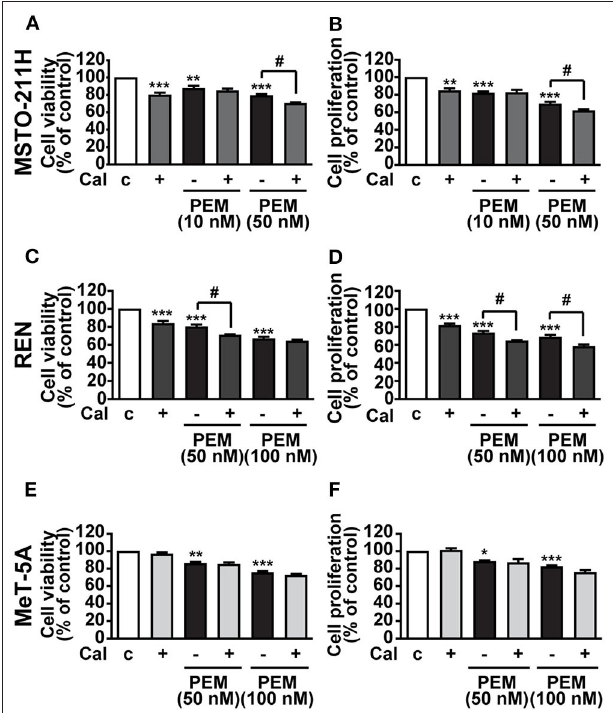
FIGURE 3 | Inhibitory effects of calcitriol in combination with PEM. Cell viability and proliferation assessed by MTT and BrdU, respectively, in MSTO-211H (A,B) and REN (C,D) cell lines, and in MeT-5A mesothelial cells (E,F) treated for 72h in medium with 2.5% serum (c, control) and with either 100nM calcitriol (Cal) alone or with pemetrexed (PEM), at the concentrations indicated. Results, expressed as percent of control, are means ± SEM. * P < 0.05, ** P < 0.01, *** P < 0.001 vs. c; # P < 0.05, n =